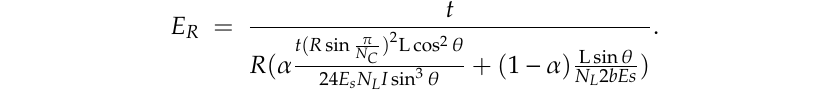
Figure 17. Elastic modulus of the auxetic stent in the radial direction at two material states: ( a ) rubbery state (high temperature); ( b ) glassy state (low temperature). Assuming the slanted members only stretch when loaded x -direction of unit cell is derived as